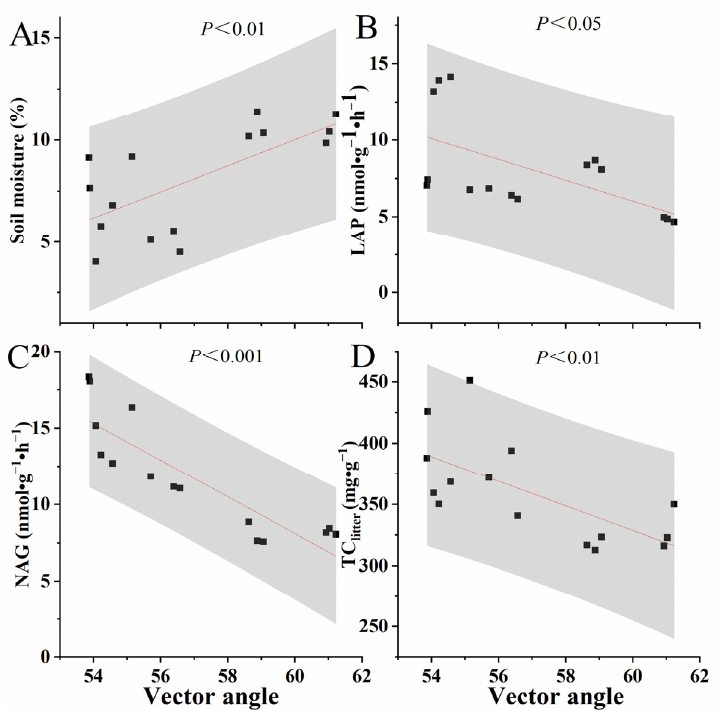
Figure 5. Linear regression analysis between the soil physical properties ( A ), soil extracellular enzymes ( B , C ), litter nutrients, ( D ) and vector angles. Red lines indicate the model fits between the vector angles and the properties; grey areas represent the 95% confidence intervals of the models.